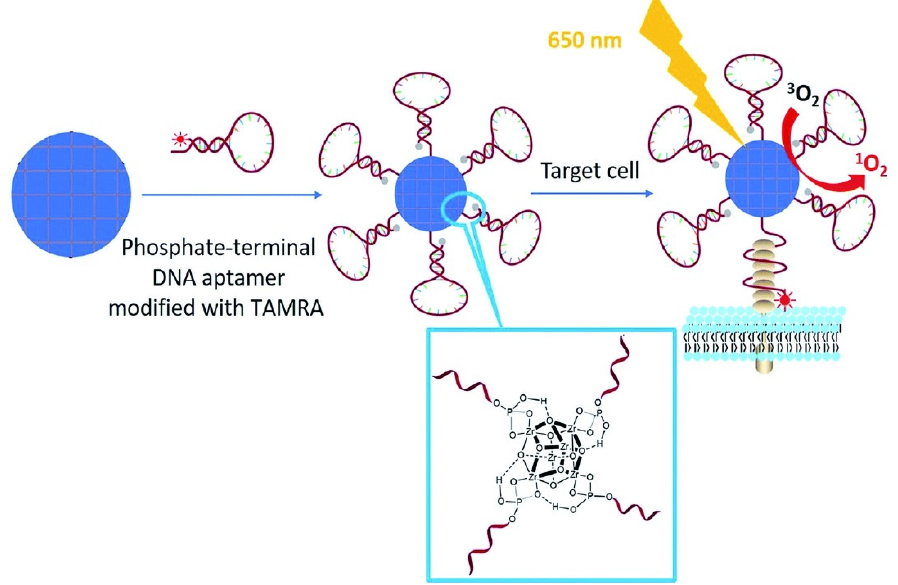
Figure 6. Illustration of phosphate-terminal DNA aptamer conjugation to a ZrPCN-222-P-DNA for target-induced imaging and photodynamic therapy. Reprinted/adapted with permission from Ref. [89] .